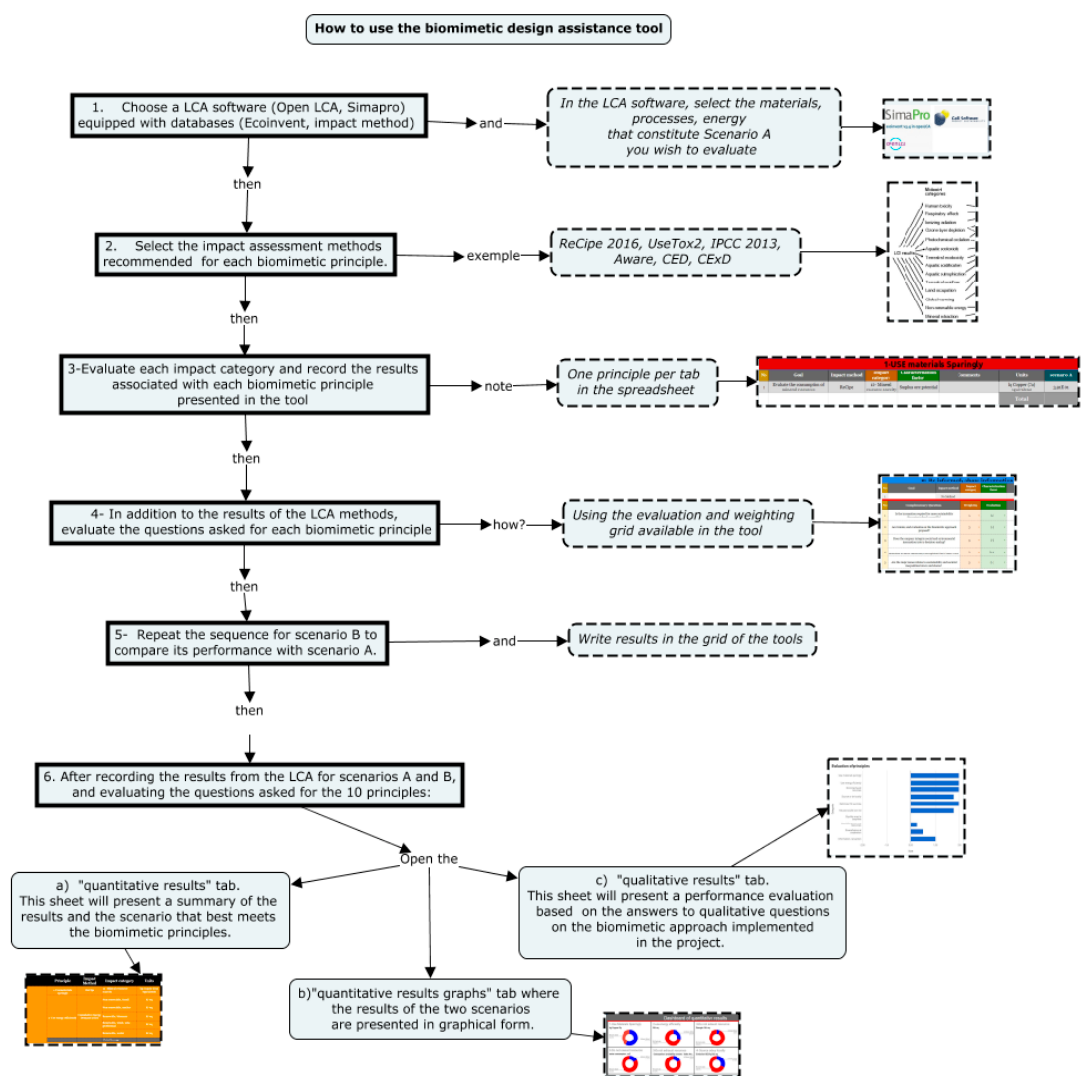
Figure 3. Algorithm for using BiomiMETRIC.